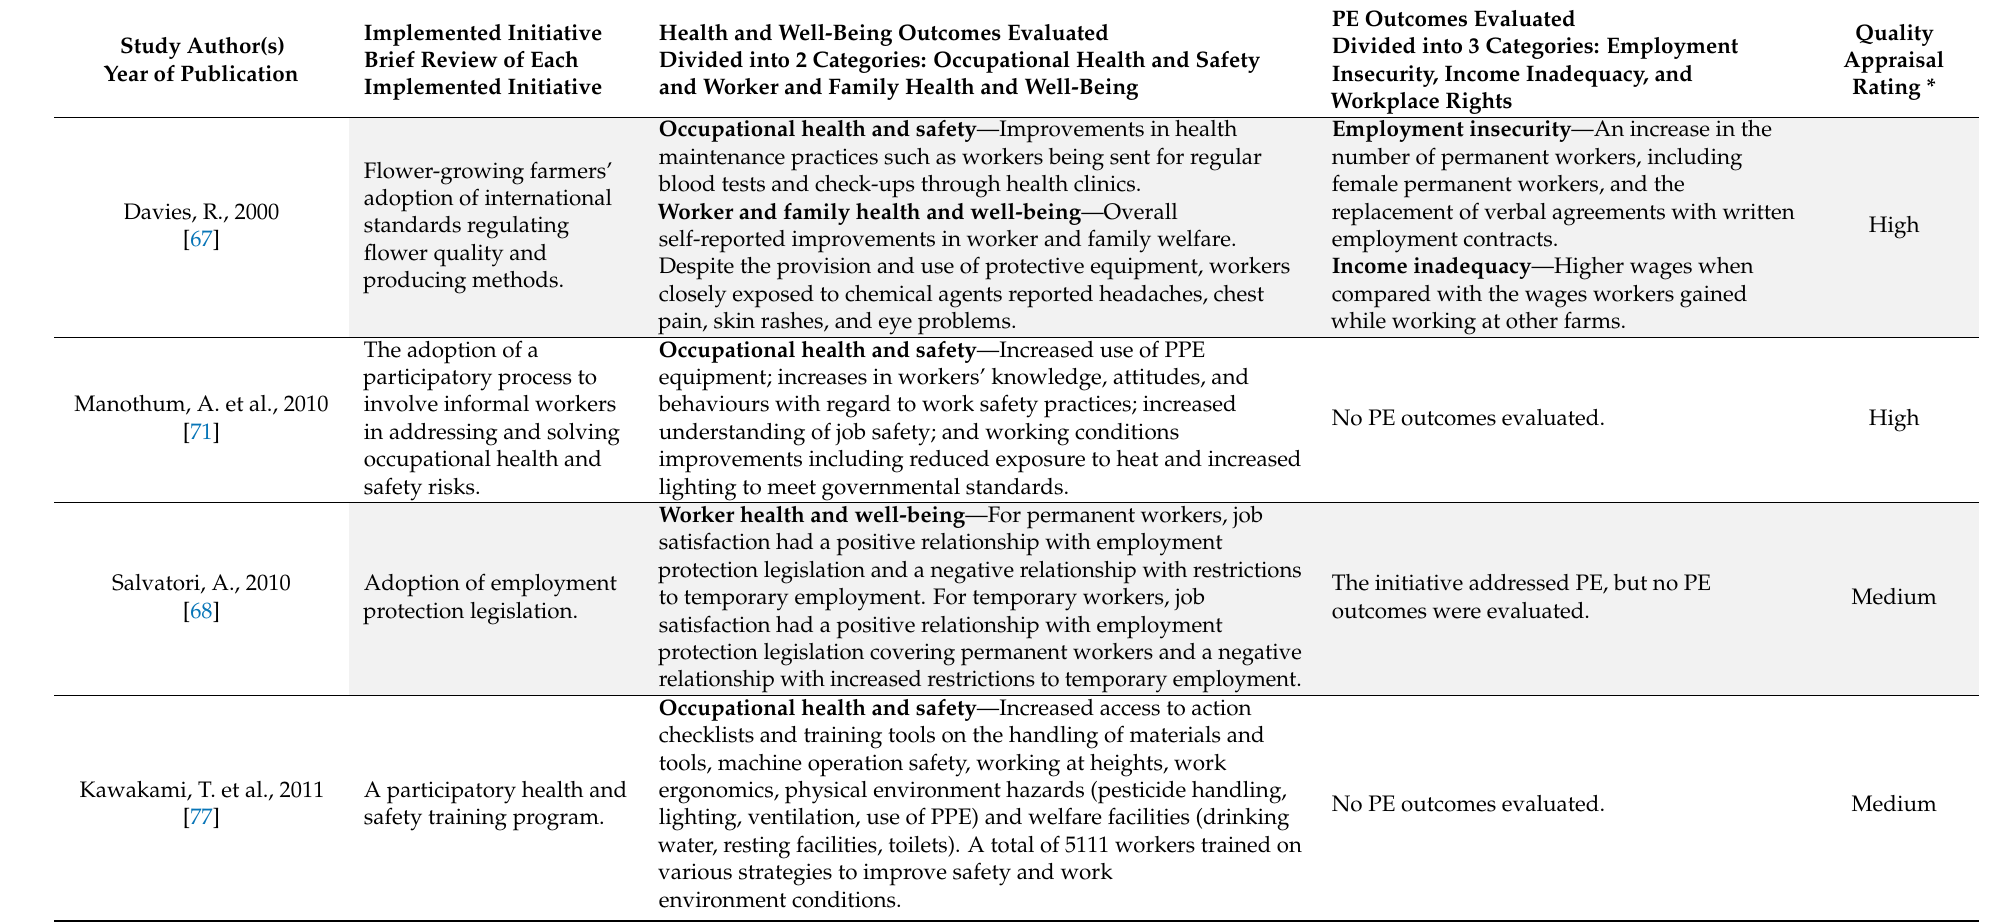
Table 4. Brief description of initiatives, health and well-being outcomes, and PE outcomes